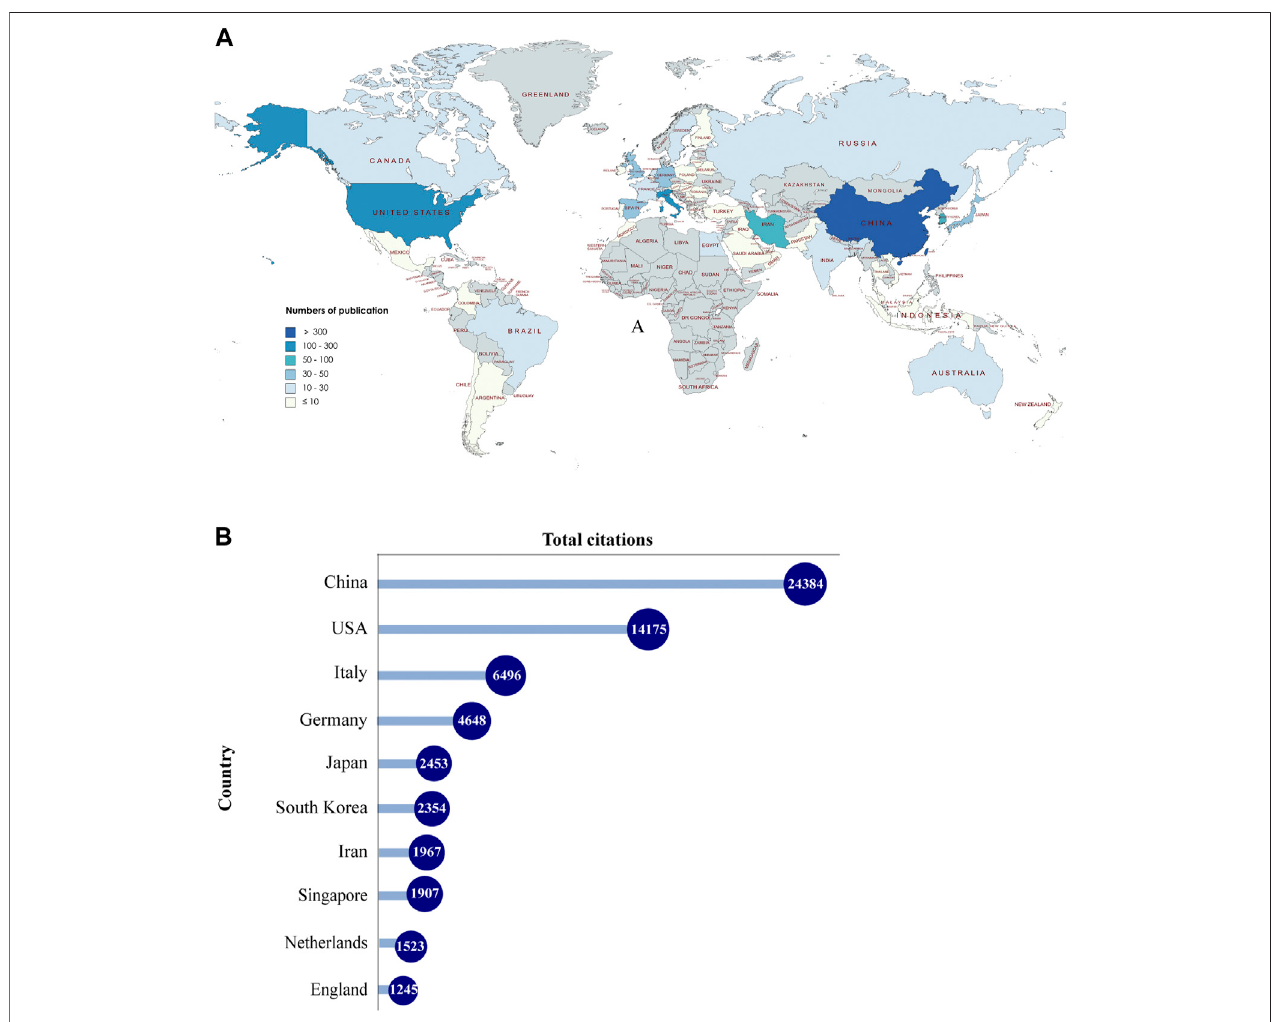
FIGURE2 | Countries contributing toMSC-EVs. (A) World map showing the distribution of countries in this fi eld. (B) Top 10countries with the most total citations.